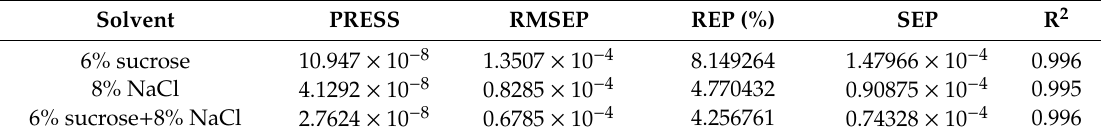
Table 8. Results of statistical parameters of the λ h